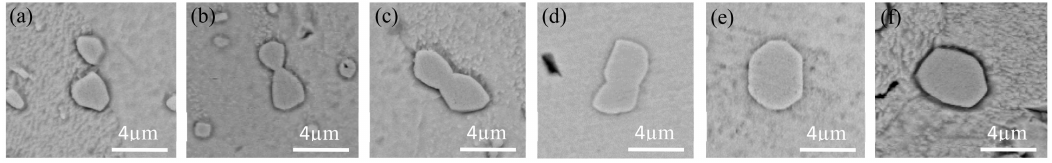
Figure 8. Microstructure evolutions of the large Ag 3 Sn particles following necking-coalescence: ( a ) the adjacent particles protruding towards each other; ( b ) two large particles bridged by a necking; ( c – f ) the necking-shaped Ag 3 Sn evolves to the uniform